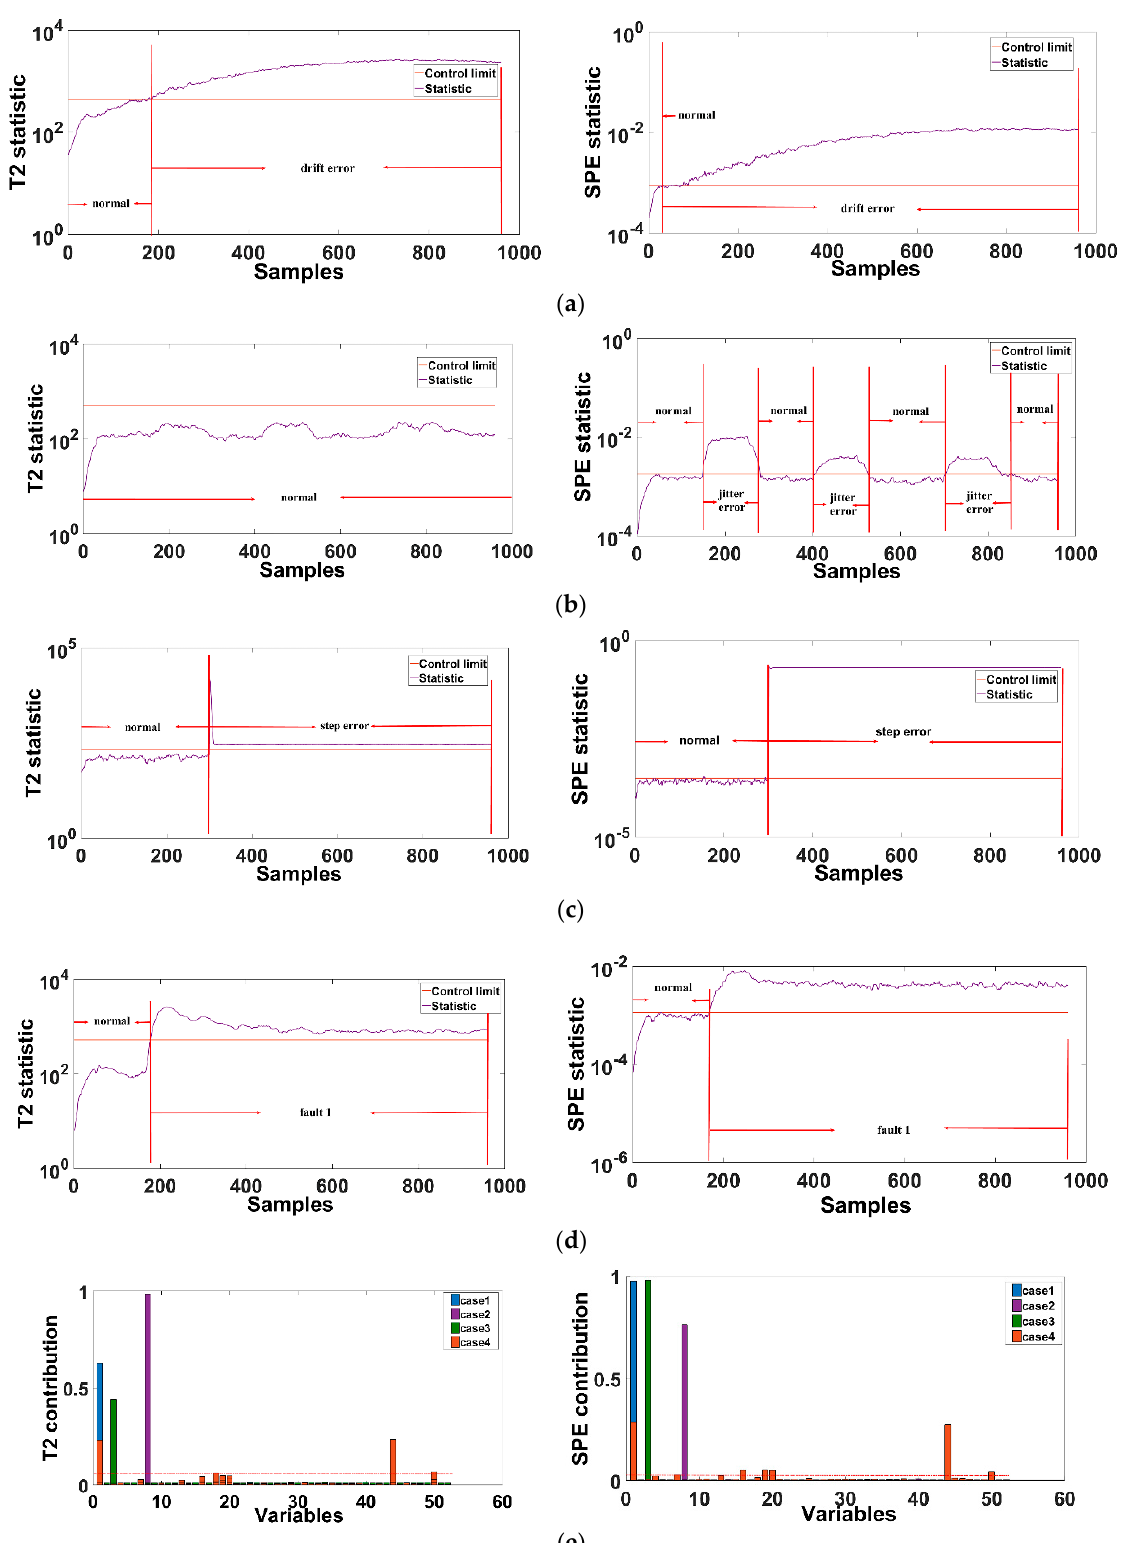
Figure 8. TE process fault diagnosis result. (( a )—case 1 fault detection result, ( b )—case 2 fault detection result, ( c )—case 3 fault detection result, ( d )—case 4 fault detection result, ( e )—fault identification result).